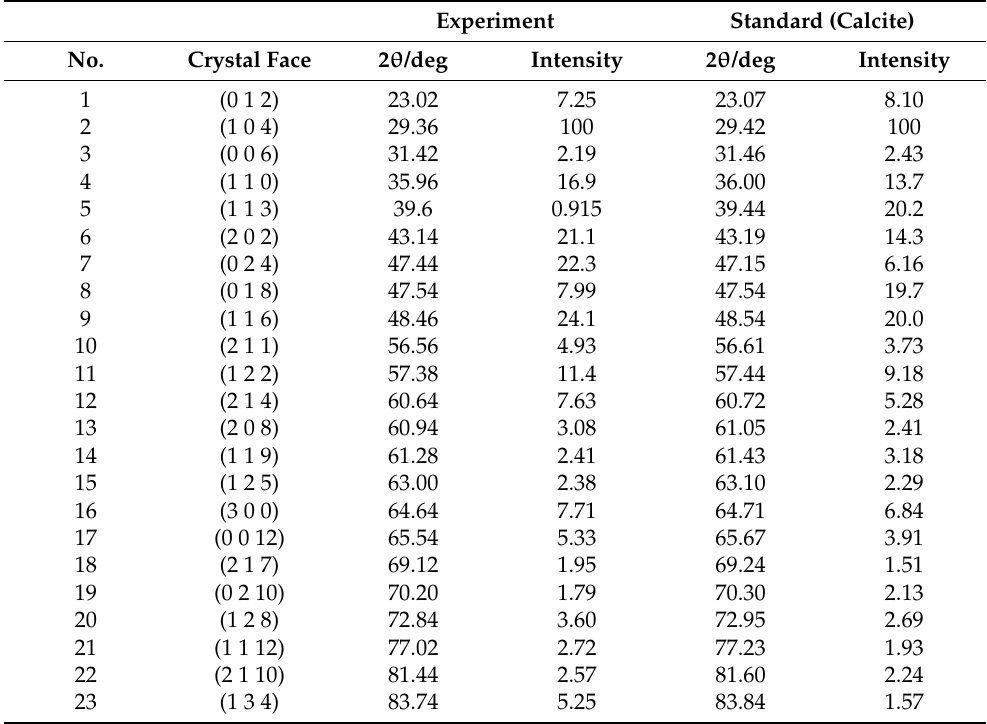
Table A1. The assignment of crystal faces from diffraction peak and relative intensity shown in Figure 5, and standard XRD data of calcite phase of CaCO 3